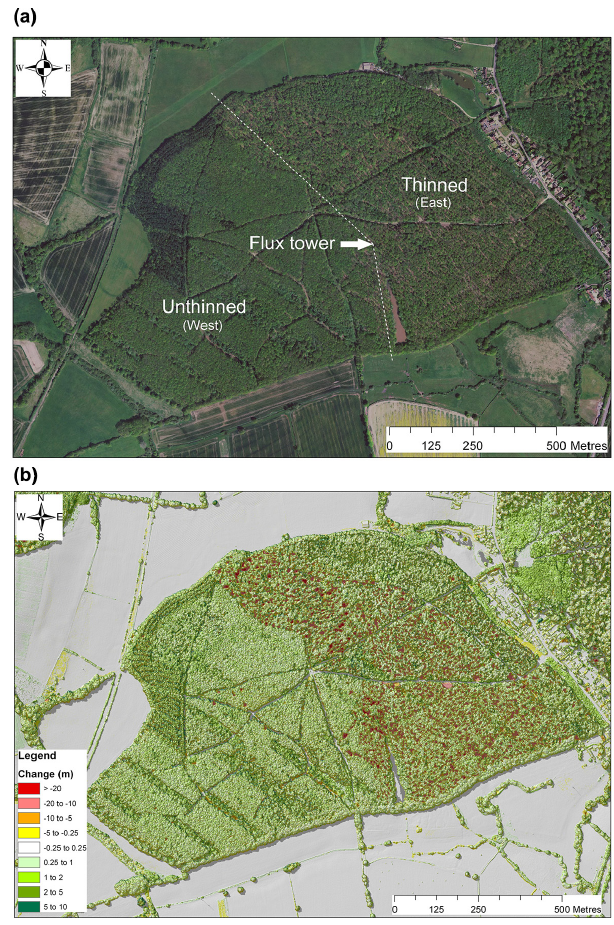
Figure 1. Panel (a) : aerial photograph (taken in spring 2008) of the Straits Inclosure, Alice Holt Forest. © Bluesky International Ltd/Getmapping PLC. Panel (b) : change in canopy height between November 2006 and August 2009 calculated using aerial lidar data at the Straits Inclosure, Alice Holt